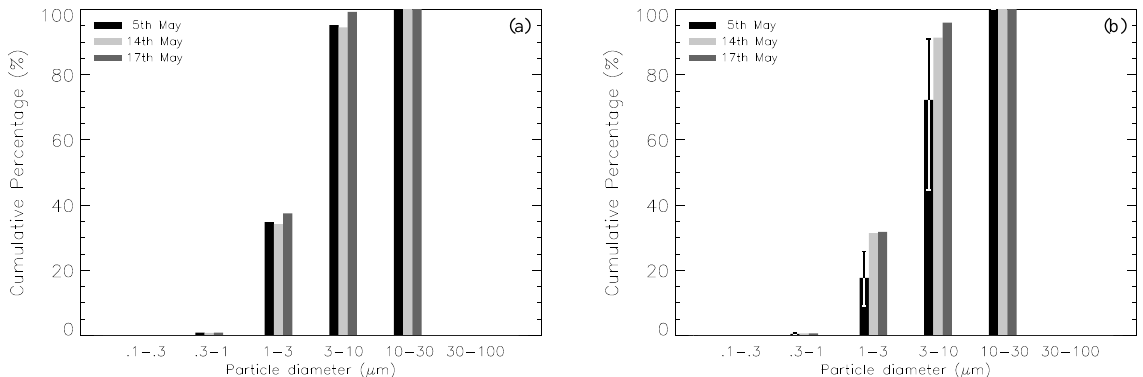
Fig. 11. Modelled column-integrated particle size distribution. (a) Due to sedimentation of particles only from NAME travel times and simple sedimentation model and (b) due to sedimentation and 3-D transport from NAME. At the location of the aircraft observation at 12:00UTC on 5 May (dashed), 13:00UTC on 14 May (dotted) and 15:00UTC on 17 May (solid). The error bars represent the range of particle size distributions simulated by NAME, at the location of the aircraft observation on 5 May, if the ash cloud is shifted 1 degree north (bottom range) or south (top range).